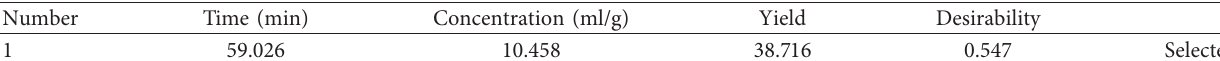
Table 8: Optimization at minimum time, concentration, and high yield.